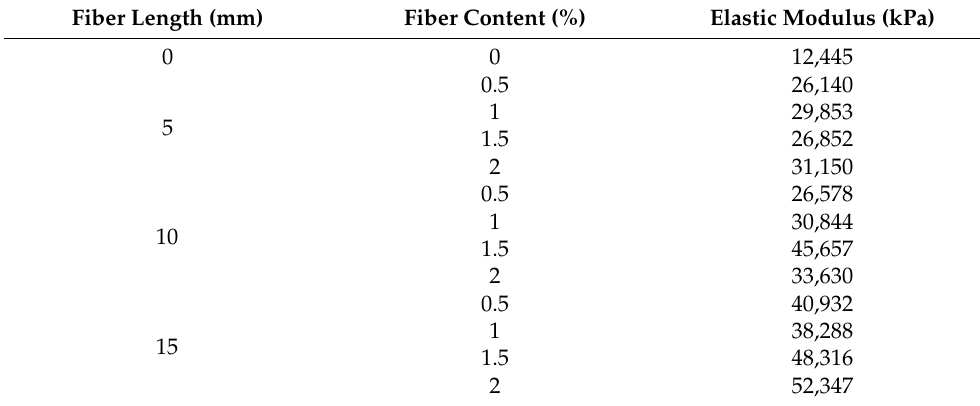
Table 7. Tangential elastic